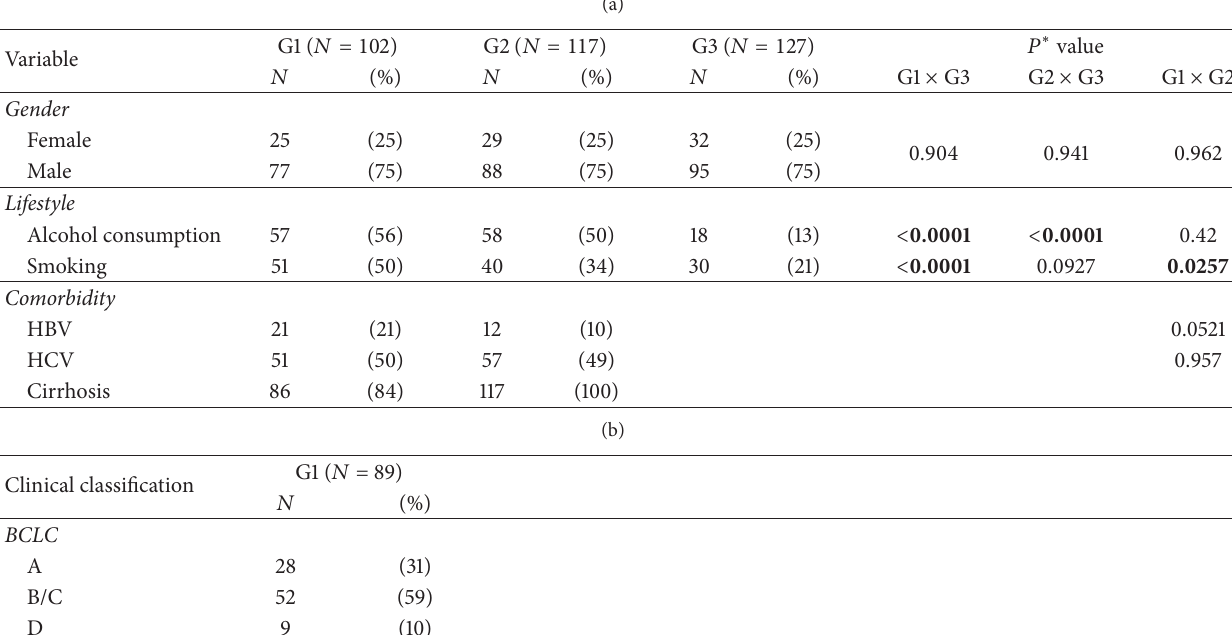
Table 1: Demographic profile, lifestyle, risk factors, and clinical classification in patients with hepatocellular carcinoma (G1), cirrhosis (G2), and individuals without the disease